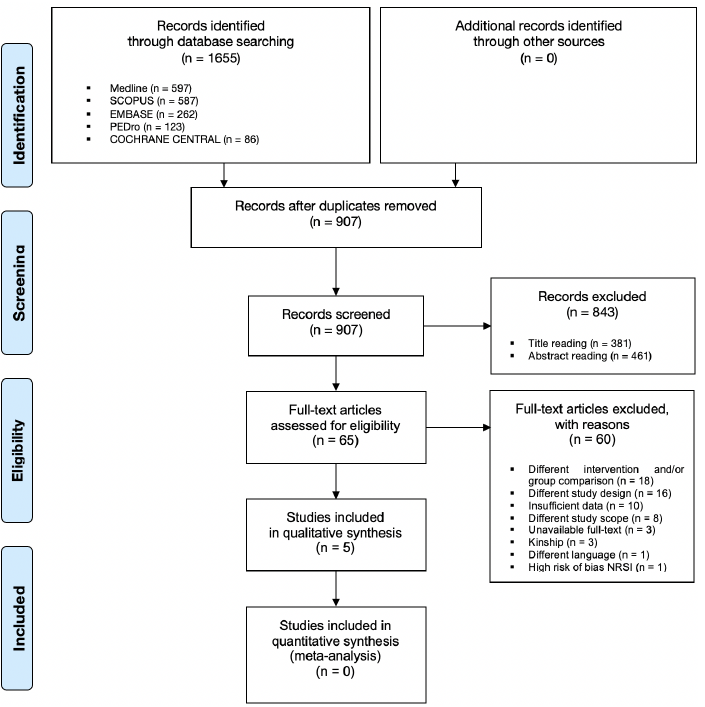
Figure 1. Prisma flowchart for search strategy results.